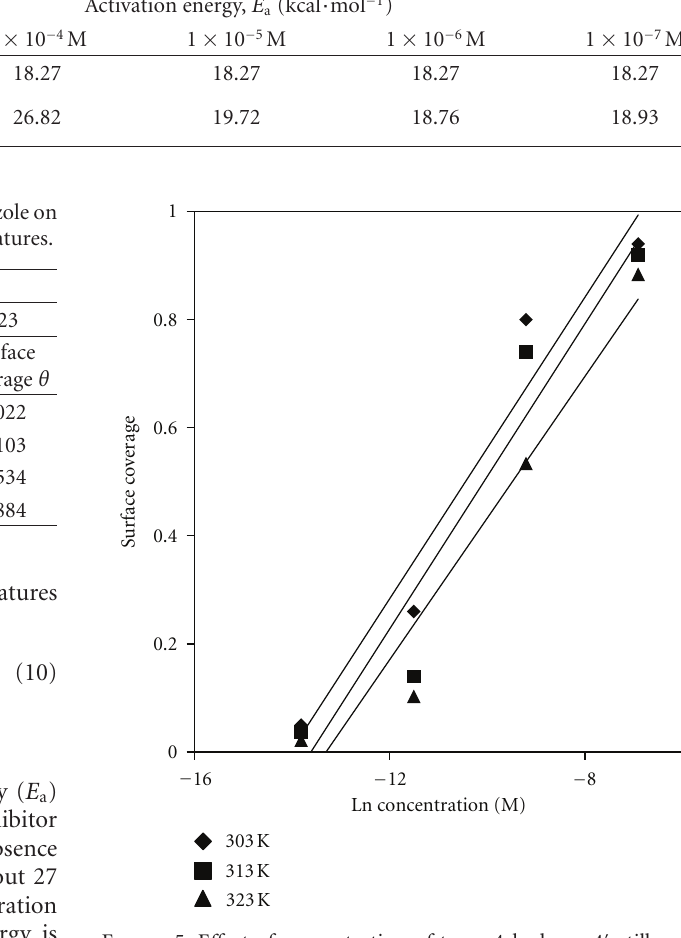
Figure 5: E ff ect of concentration of trans-4-hydroxy-4 (cid:2) -stilbazole on the surface coverage of mild steel in 1 M HCl at various temperatures.